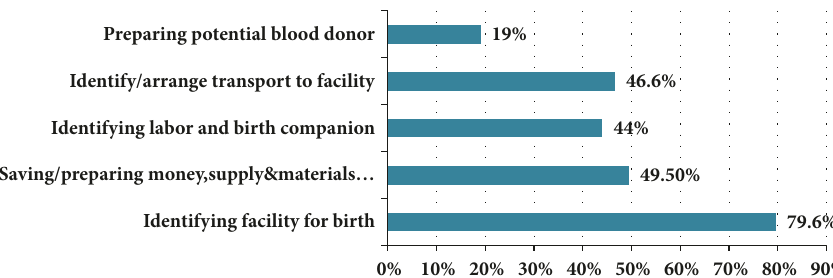
Figure 1: BP/CR elements mentioned by pregnant women in Debre Markos town,